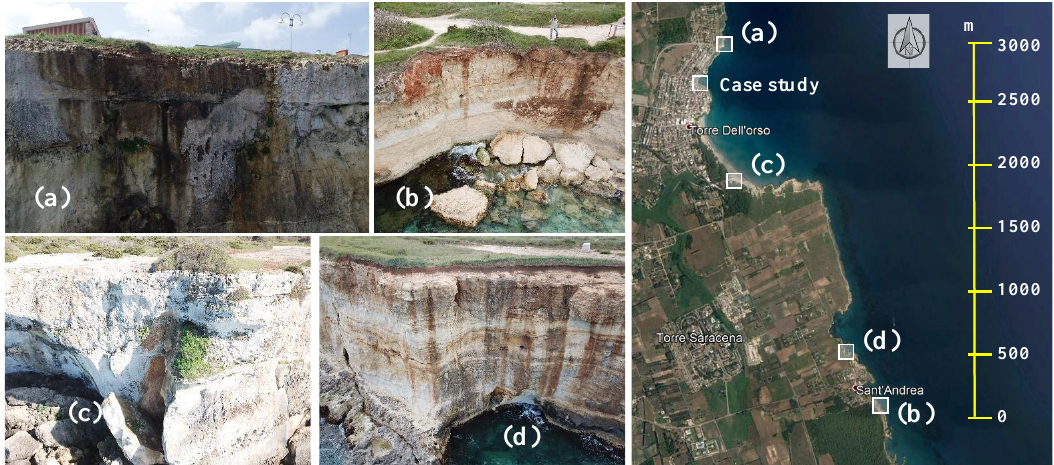
Figure 2. Typical calcarenitic outcrops of sea cliffs, with location (Google Earth ® ), in the marine area of Melendugno: ( a ) North area of Torre dell’Orso; ( b ) Southern area of Sant’Andrea; ( c ) Southern area of Torre dell’Orso; ( d ) North area of Sant’Andrea.